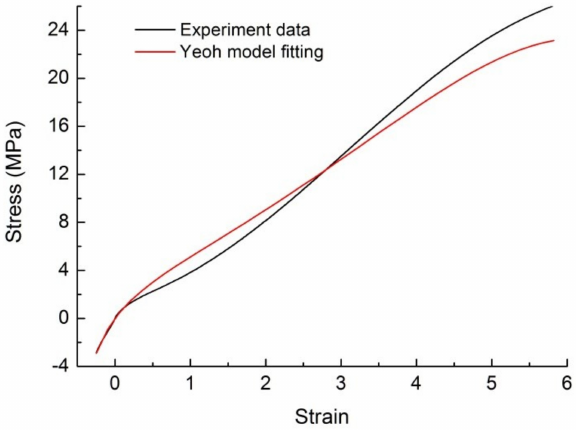
Figure 3. The experimental stress–strain curves and the data fitting of the Yeoh model.